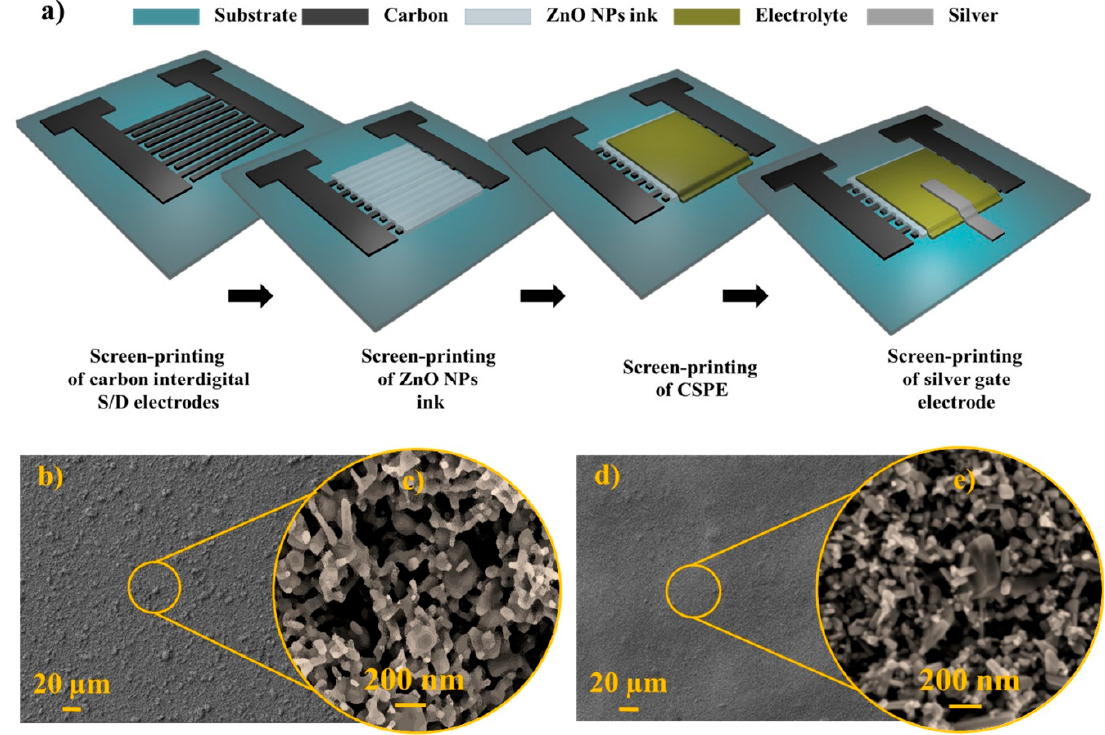
Figure 1. ( a ) Schematic representation of the fabrication steps for the fully printed ZnO electrolyte- gated transistors (EGTs). ( b , c ) Topographical view of the screen-printed layer using ZnO10 ink. ( d , e ) Topographical view of the screen-printed layer using ZnO40 ink.